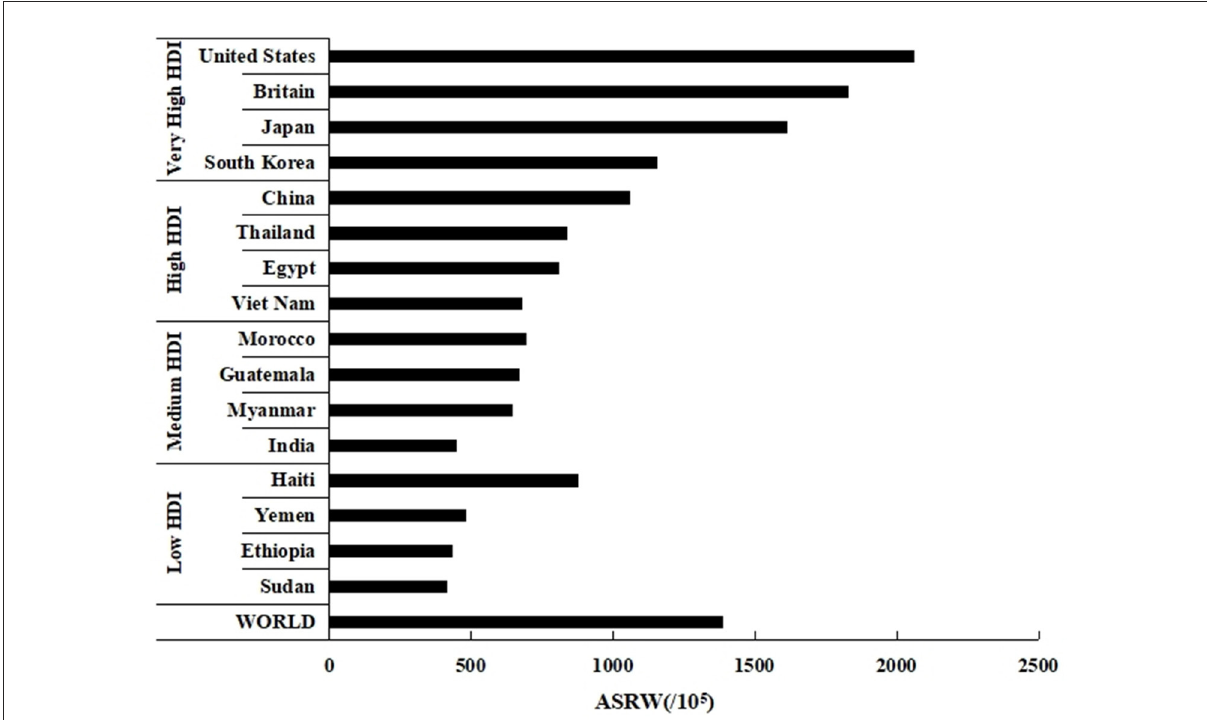
FIGURE1 Estimated age-standardized incidence rates of cancers in older adults aged 60 and above in countries with different HDI in 2020 (Date source: GLOBOCAN 2020, https://gco.iarc.fr/today/).